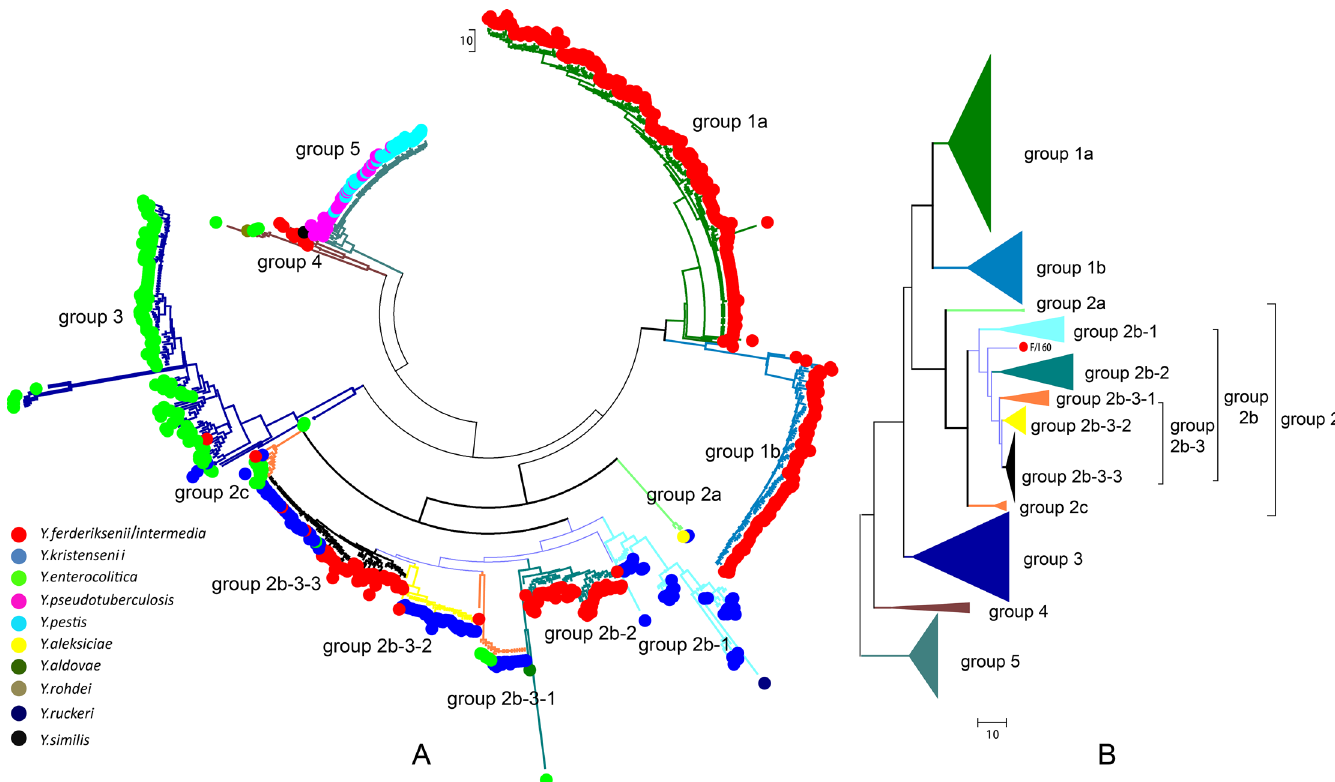
Fig 2. A phylogenetic tree constructed on the basis of the five copies of 16S rRNA gene in each strain using the minimum evolution method. A. Dots with different colors represent the corresponding Yersinia species; tree branch colors are consistent with triangles in B. , which represent different clustering